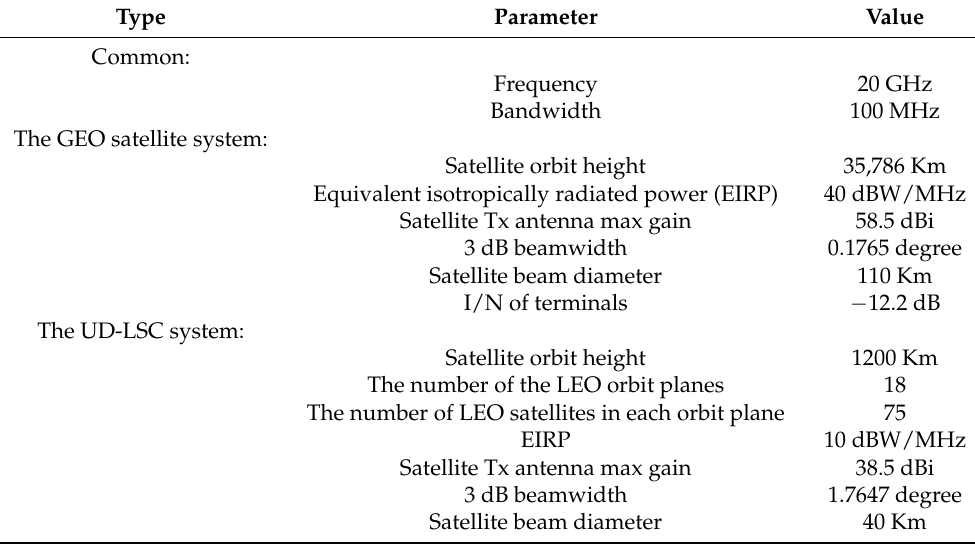
Table 1. The main parameters of UD-LSC and GEO satellite